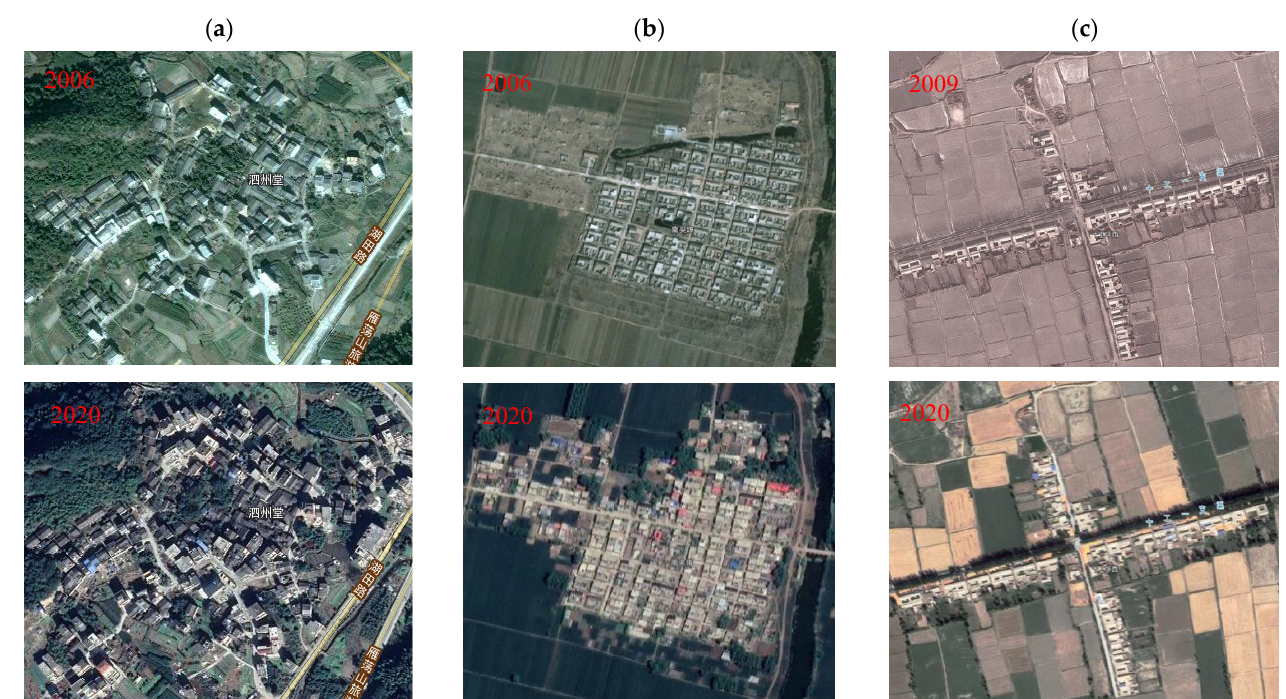
Figure 4. Satellite images of changing rural settlements in different regions of China. ( a ) Low hilly region of southeast China (Sizhoutang Village, Yueqing County, Zhejiang Province); ( b ) an agricultural region on the eastern plains of China (Nanjiabu Village, Tancheng County, Shandong Province); ( c ) arid and semi-arid region of northwest China (Shigongping Village, Guazhou County, Gansu Province).